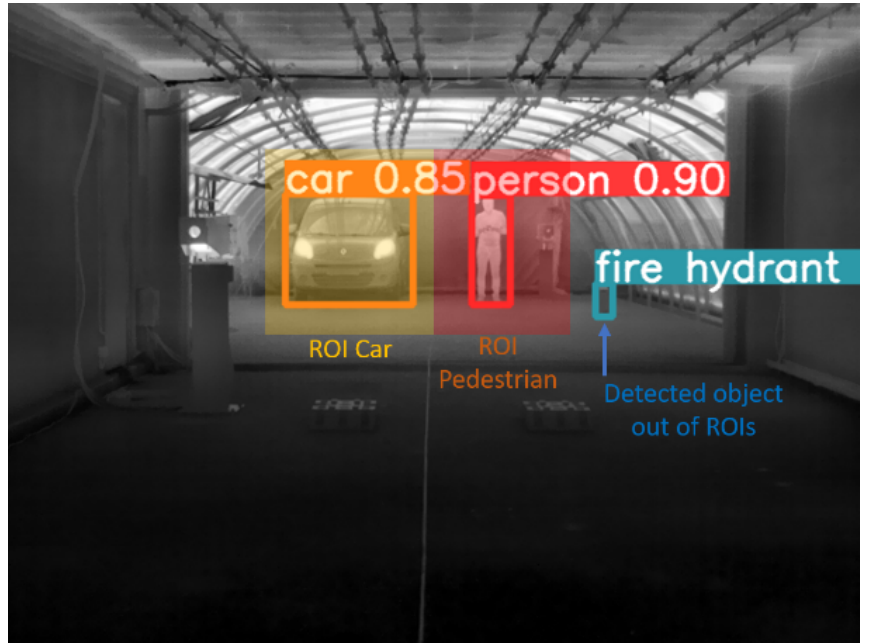
Figure 23. Example of output obtained from YOLOv5 and application of ROIs for discrimination in object detection. Table 4. Detection rates obtained from YOLO. MOR from 10 m to 15